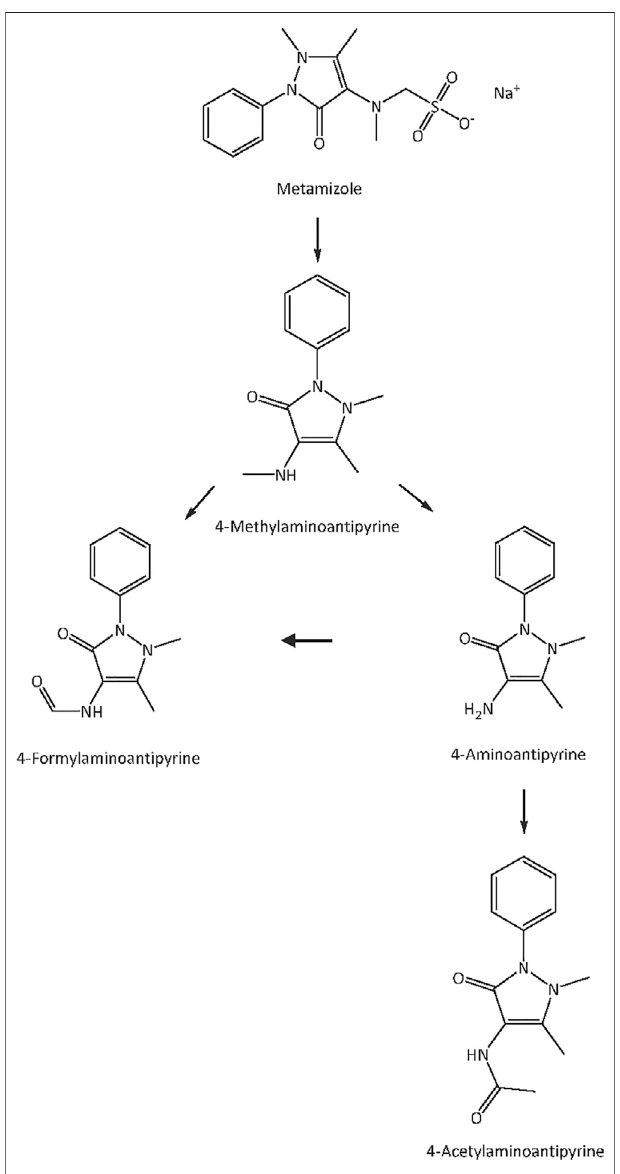
FIGURE 1 | Metabolism of metamizole. The prodrug metamizole is non- enzymatically cleaved to 4-N-methylaminoantipyrine (4-MAA), which is N-demethylated to 4-aminoantipyrine (4-AA). 4-AA can be N-formylated to 4- N-formylaminoantipyrine (4-FAA) or N-acetylated to 4-N- acetylaminoantipyrine